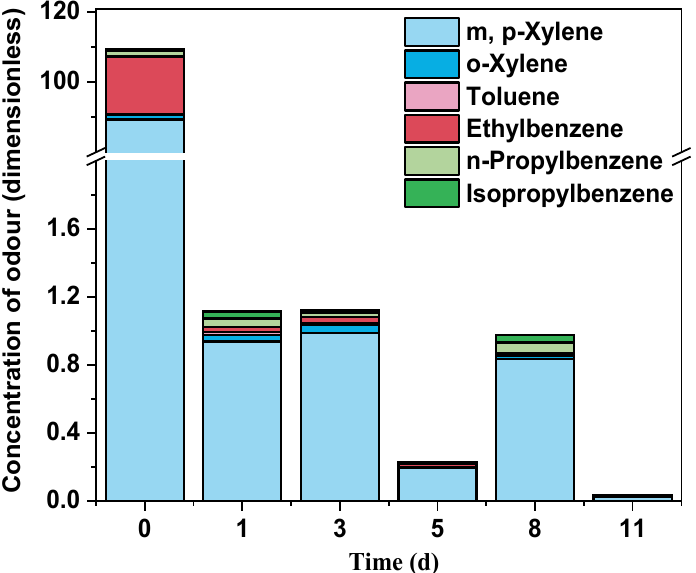
Figure 4. Odour concentration and odour activity value (OAV) of main odours in the test